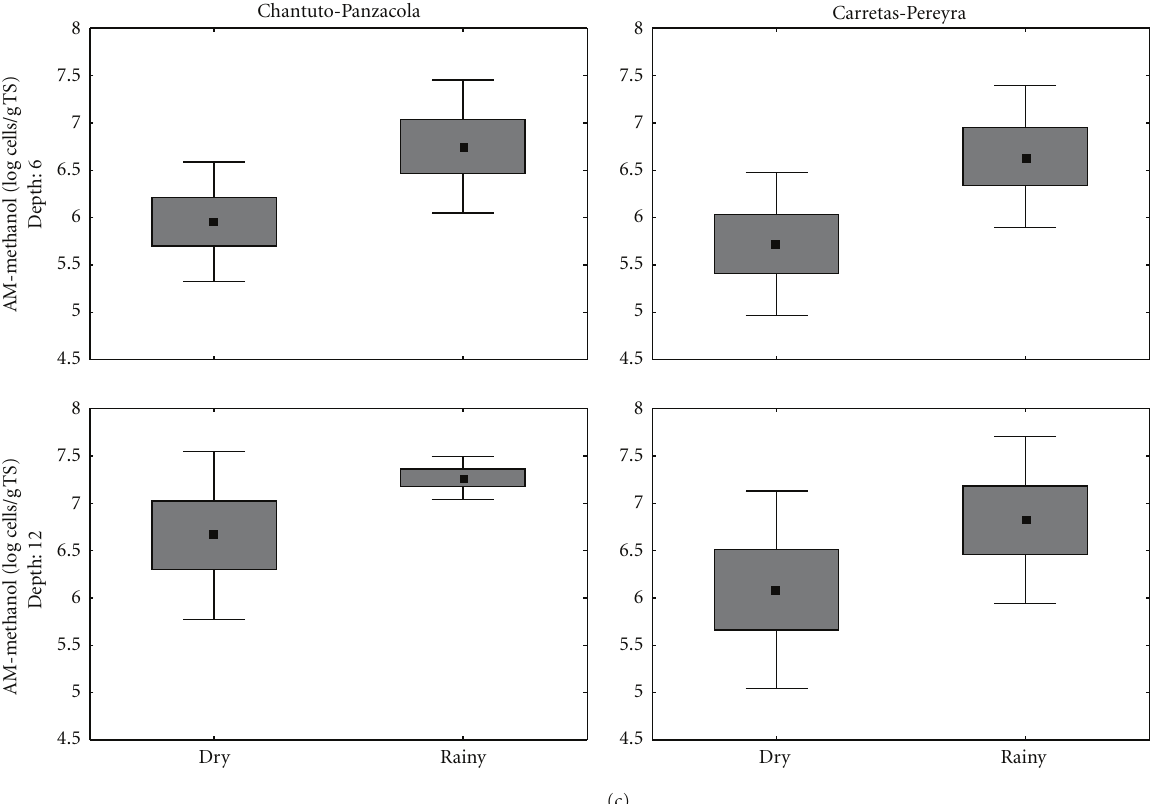
F 2: Temporal and spatial variation in the abundance of MA (log cells/g TS).